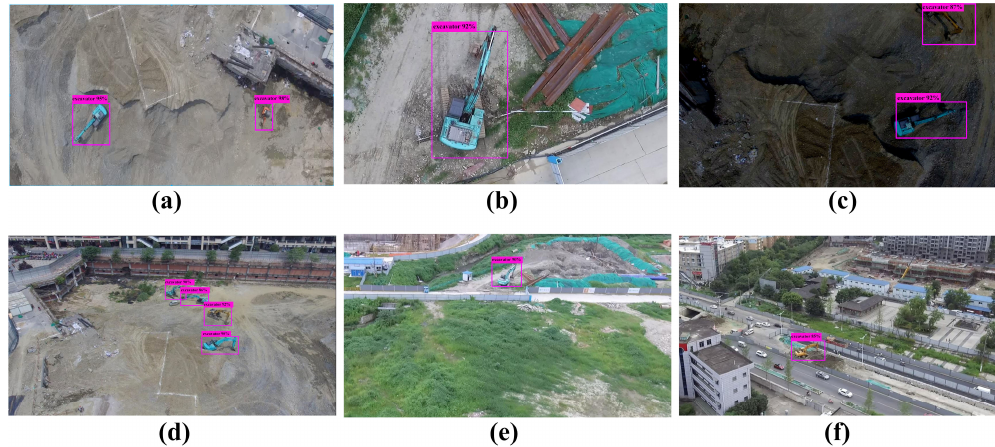
Figure 8. The excavators detected from the testing images by the trained excavator detection model. The original images of ( a – c ) were taken vertically by the UAV and that of ( d – f ) were taken obliquely.